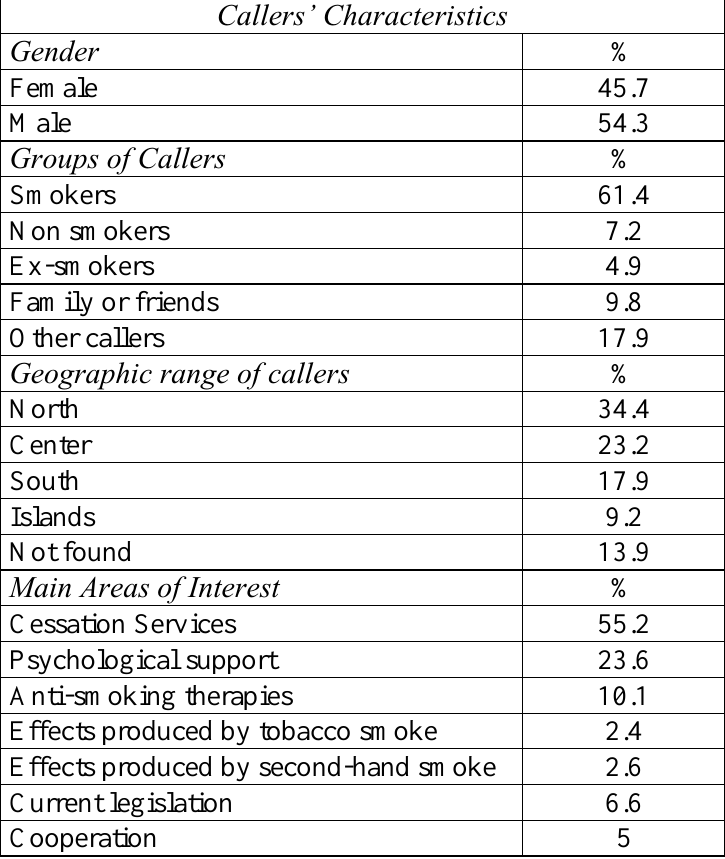
Table 2. Characteristics of Italian Antismoking Helpline